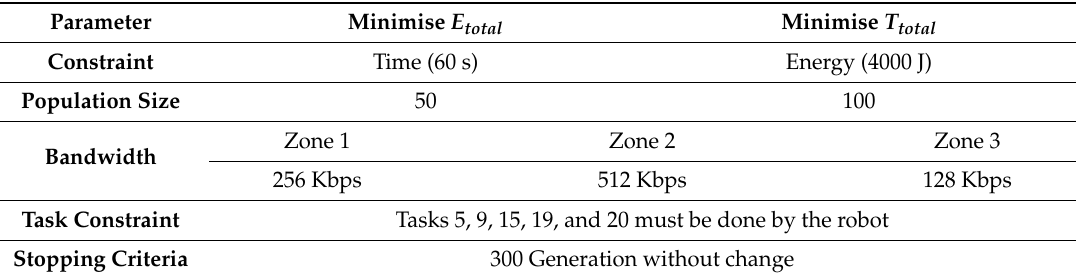
Table 2. Simulation parameter setup for the 20-node task